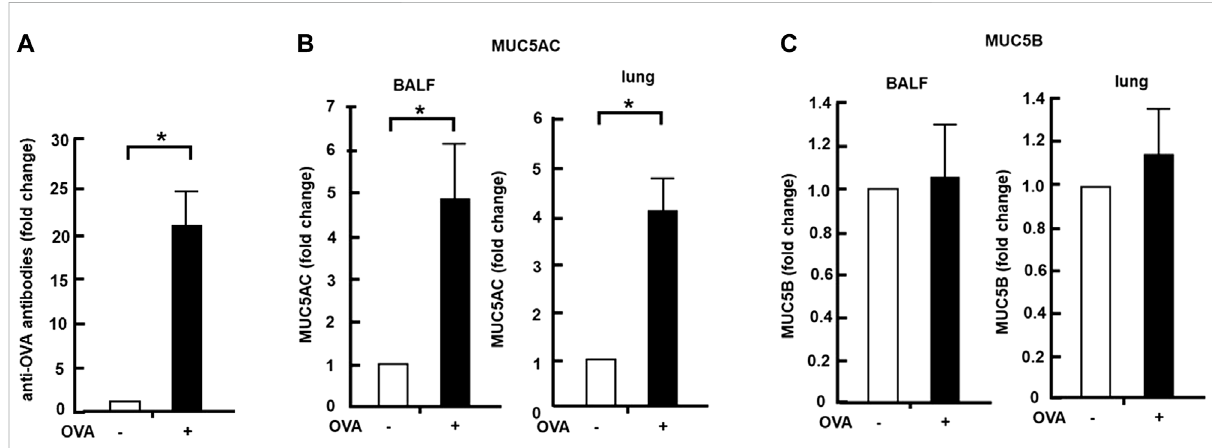
FIGURE 2 Effects of Col4 on cellular and secreted mucin 5AC (MUC5AC) and mucin 5B (MUC5B) levels in ovalbumin (OVA)-sensitized mice. (A) Blood samples were collected from the OVA-sensitized (+) and control mice groups ( − ), and the amount of antibodies to OVA present in the blood sample wasdetectedusingtheenzyme-linked immunoassay method. (B) MUC5AC levels inbronchoalveolarlavage fl uid(BALF)orlungtissue sampleswere detected using the dot-blot method in the OVA-sensitized mice (+) and unsensitized control mice ( − ). (C) MUC5B levels in BALF or lung tissue samples were detected using the dot-blot method in the OVA-sensitized mice (+) and unsensitized control mice ( − ). The MUC5AC and MUC5B protein levels in the lung tissue samples were normalized to the GAPDH levels before analysis. Fold changes were based on the ratio between the values [mean ± standard deviation (SD), n = 5]. A student ’ s t-test was used to obtain the p -values. Asterisks indicate statistical signi fi cance, * p < 0.05. Representative results of three independent experiments are presented in this fi